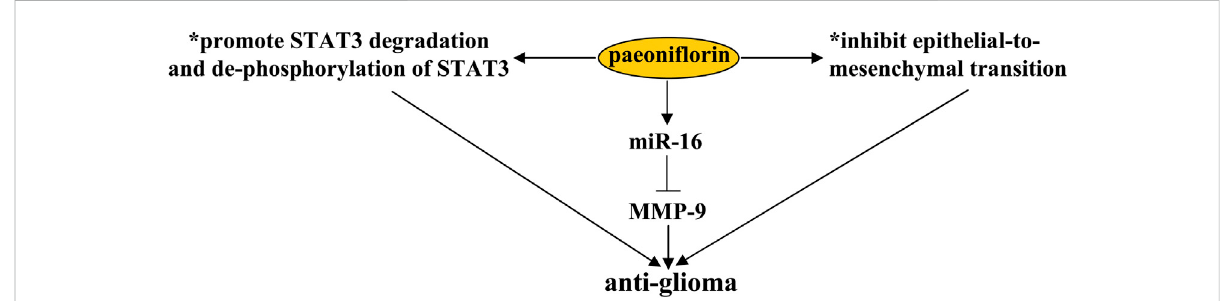
Effects and mechanisms of paeoni fl orin in glioma. Paeoni fl orin administration can suppress glioma growth by promoting STAT3 degradation and de-phosphorylation of STAT3 and inhibiting epithelial-to-mesenchymal transition. Increasing the expression of miR-16 is another mechanism for the anti-glioma effect of paeoni fl orin. The increased miR-16 upon paeoni fl orin treatment induces glioma cell apoptosis by down-regulating MMP-9